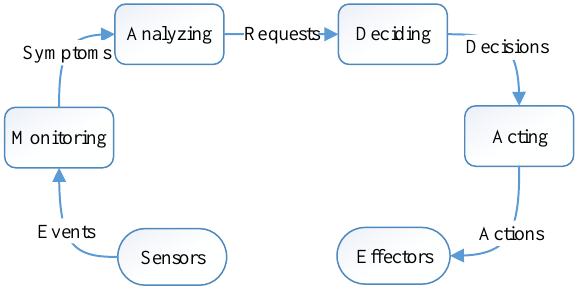
Figure 1. The system-centric self-management process of AC Systems.